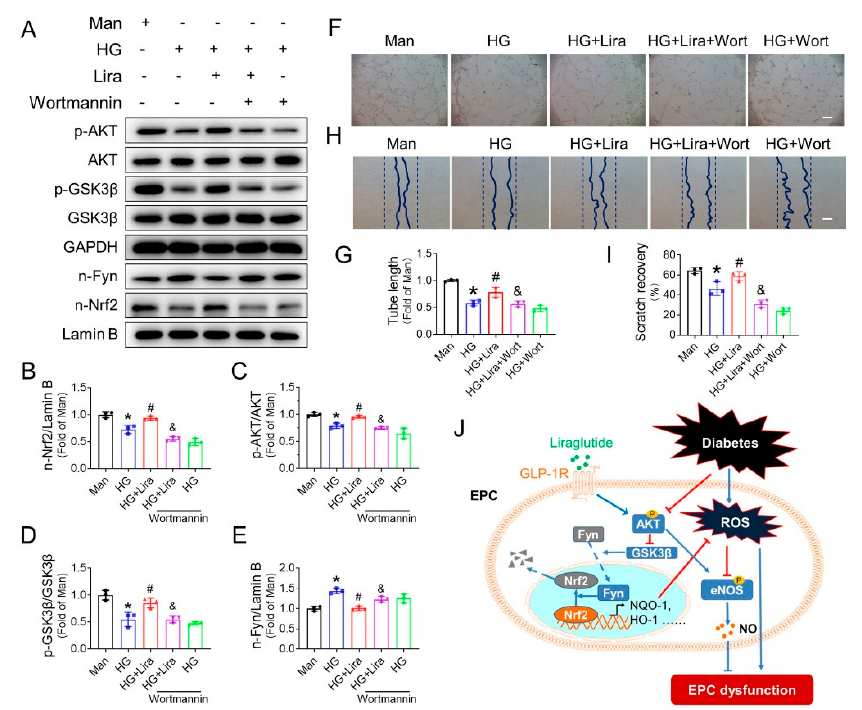
Figure 8. Liraglutide activates Nrf2 via the AKT-GSK3 β -Fyn pathway. The nuclear content of Nrf2 ( A , B ), the phosphorylation of AKT ( A , C ) and GSK3 β ( A , D ), and nuclear content of Fyn ( A , E ) in HG-treated EPC receiving liraglutide treatment in the presence or absence of wortmannin were determined by western blot and quantified using Imagequant. The effect of wortmannin on liraglutide improving angiogenic function of HG-treated EPC was evaluated by Matrigel tube formation assay ( F ) and quantified using Image J ( G ). The effect of wortmannin on liraglutide enhancing migratory function of HG-treated EPC was investigated by cell scratch assay ( H , I ). Three independent experiments were performed for each study. * p < 0.05 vs. Man group; # p < 0.05 vs. HG group, & p < 0.05 vs. HG + Lira. Bar = 100 µm. ( J ) Schematic illustration of the protective effects of liraglutide on EPC under diabetic conditions. Diabetes mellitus induces oxidative stress, which impairs the angiogenic function of EPC. Liraglutide improves EPC function predominantly via Nrf2 activation mediated by increased phosphorylation of AKT and GSK-3 β and inhibiting Fyn-mediated export and degradation of nuclear Nrf2. NQO-1, NAD(P)H dehydrogenase (quinone1); HO-1, heme oxygenase-1; ROS, reactive oxygen species; eNOS, endothelial nitric oxide synthase; NO, nitric oxide.